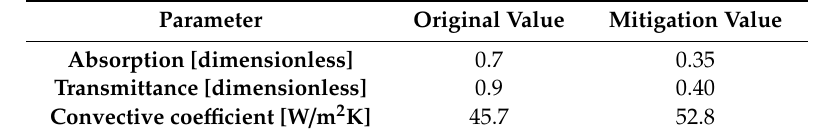
Table 2. Parameters of calculation to decrease the UHI effect.